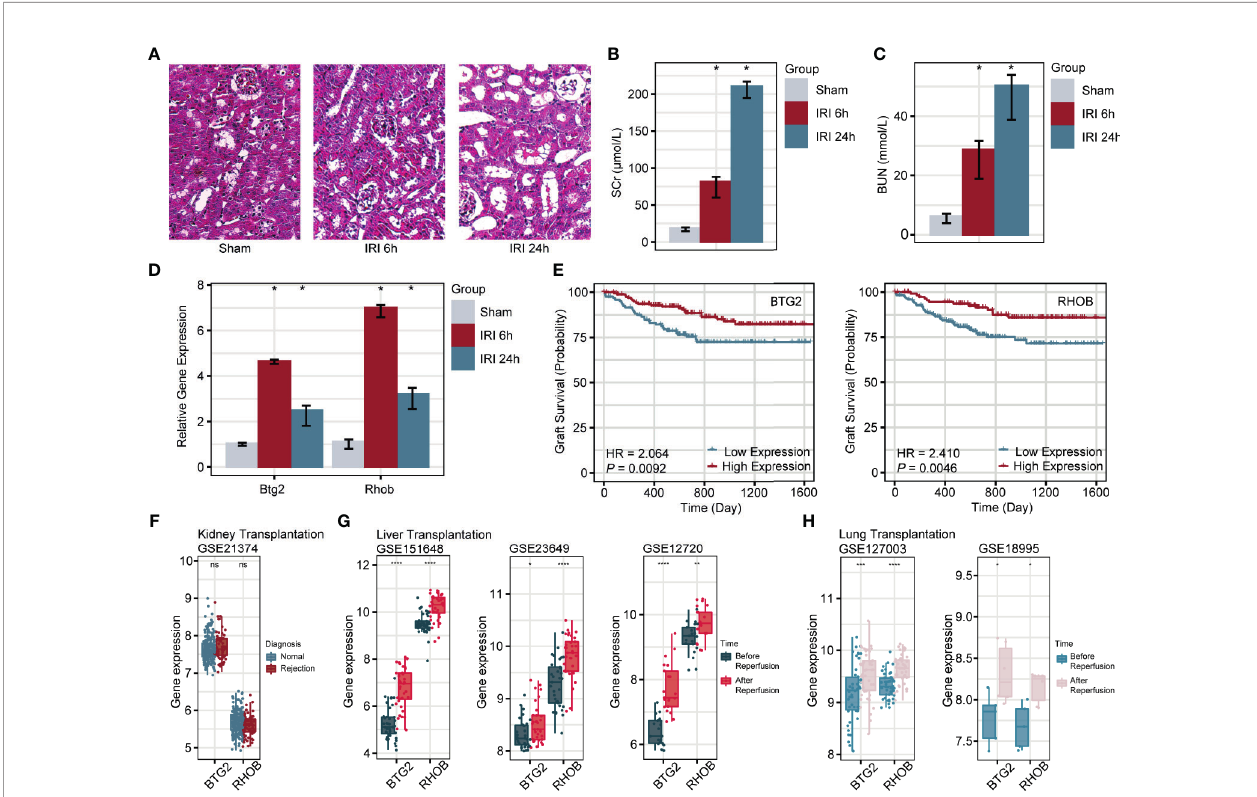
FIGURE 5 | Veri fi cation of Btg2 and Rhob in a mouse model and comprehensive analysis in clinical cohorts. HE staining of renal tissues from sham and 6-h post- IRI, and 24-h post-IRI groups (A) . Histograms illustrate differences in SCr (B) , BUN (C) , Btg2 , and Rhob expression (D) among sham, 6-h post-IRI, and 24-h post- IRI groups. (E) K-M survival curves for Btg2 and Rhob . (F) Expression levels of Btg2 and Rhob between normal and rejection groups. Differential expression patterns of Btg2 and Rhob before and after reperfusion in liver (G) and lung transplantations (H) . * p < 0.05; ** p < 0.01; *** p < 0.001; **** p < 0.0001; ns, not statistically signi fi cant. HE, hematoxylin – eosin; SCr, serum creatinine; BUN, blood urea